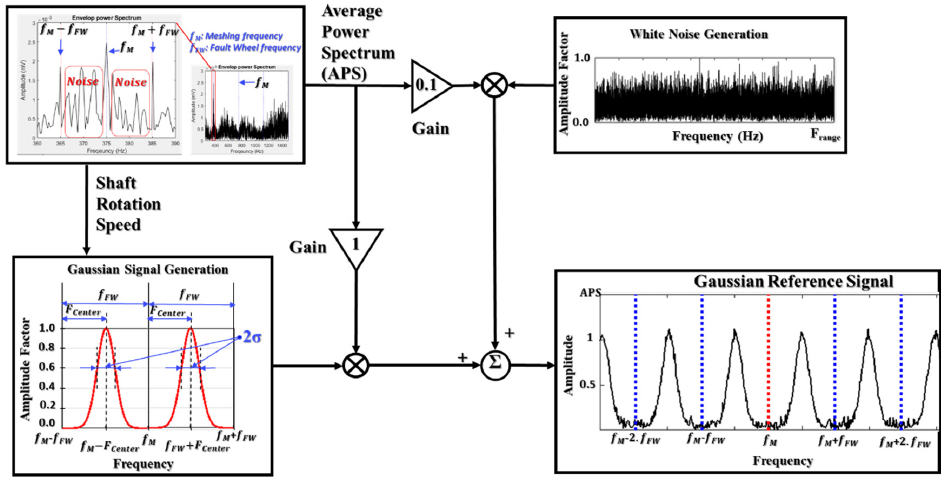
Figure 9. The overall flow chart of GRS signal generation for the ANR-GRS module.